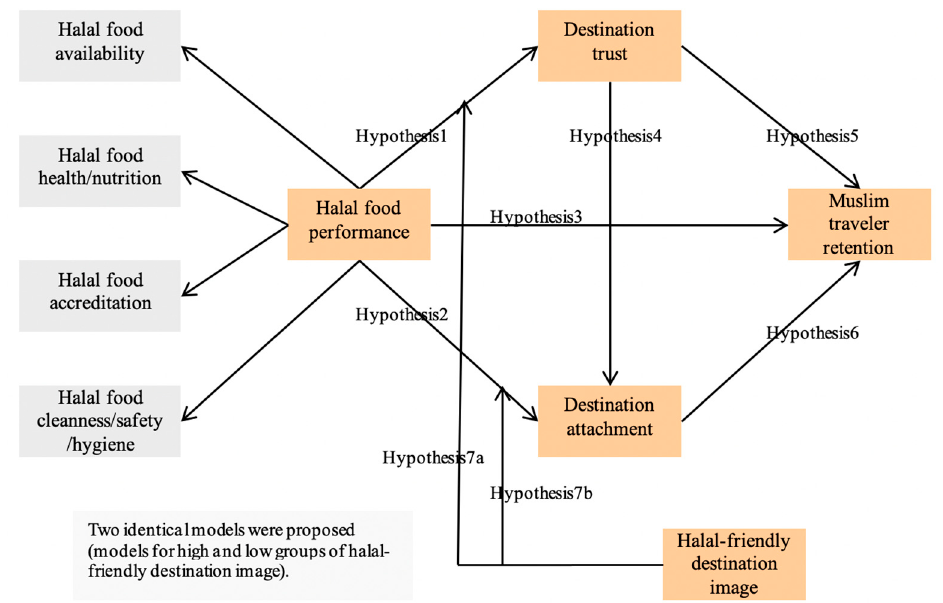
Figure 1. The proposed conceptual framework. H1: Halal food performance includes a positive effect on destination trust. H2: Halal food performance includes a positive effect on destination attachment. H3: Halal food performance includes a positive effect on Muslim traveler retention. H4: Destination trust includes a positive effect on destination attachment. H5: Destination trust includes a positive effect on Muslim traveler retention. H6: Destination attachment includes a positive effect on Muslim traveler retention. H7a: Halal-friendly destination image includes a significant effect on the relation between halal food performance and destination trust. H7b: Halal-friendly destination image includes a significant effect on the relation between halal food performance and destination attachment.